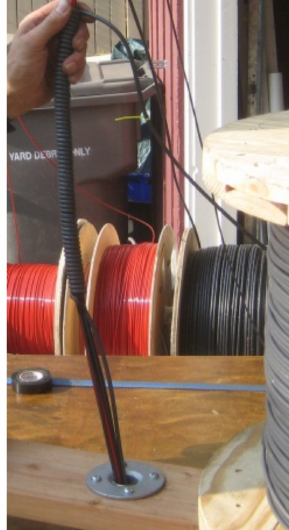
Figure 3. A wrapped section, or heating “dot,” on the cable assembly. In the background the two spools of red fiber optic cable are seen, and to the right, the heavy power feed cable, and to the far right the vertical spool of wrapping cable which was on a rotating holder that allowed wrapping around the other four cables (the linear heating cable spool is not